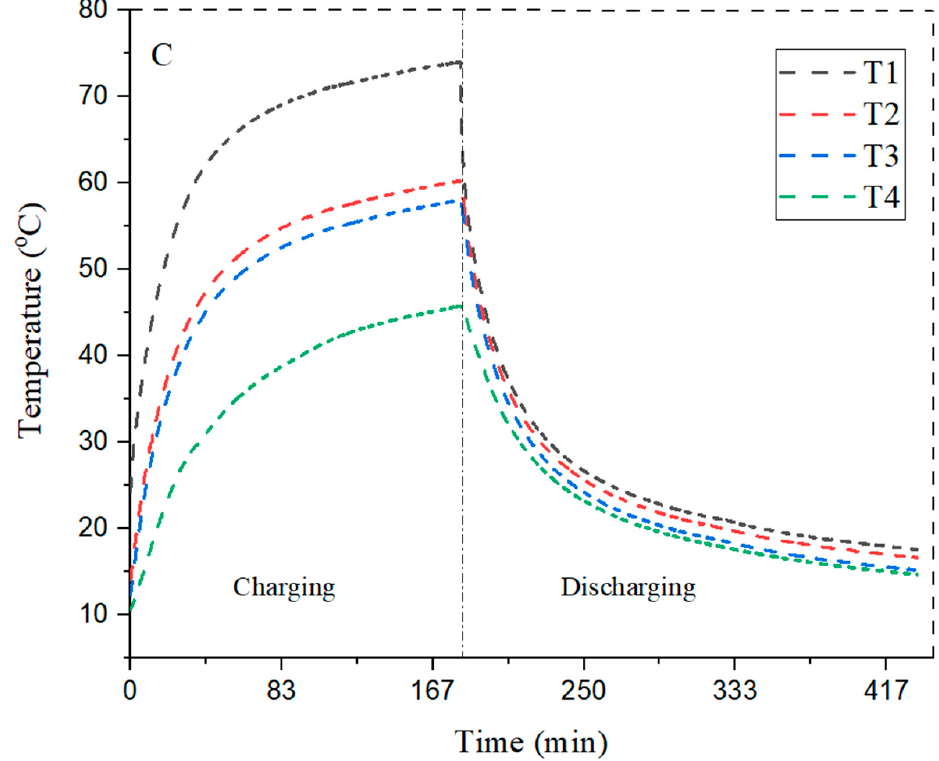
Figure 7. Comparison of different configurations without PCM ( A ) circular, ( B ) square, and ( C ) triangular fins. Table 3. Temperature data for configuration without